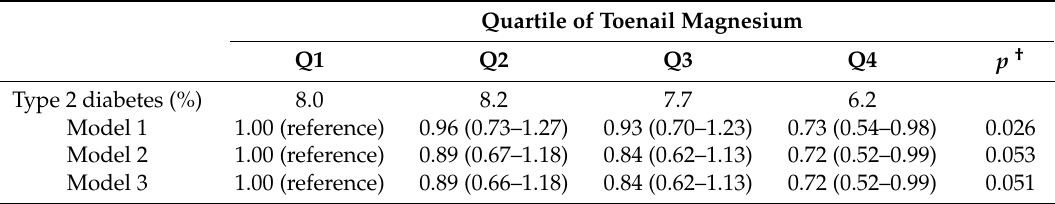
Table 3. Association between toenail magnesium and type 2 diabetes in the study population